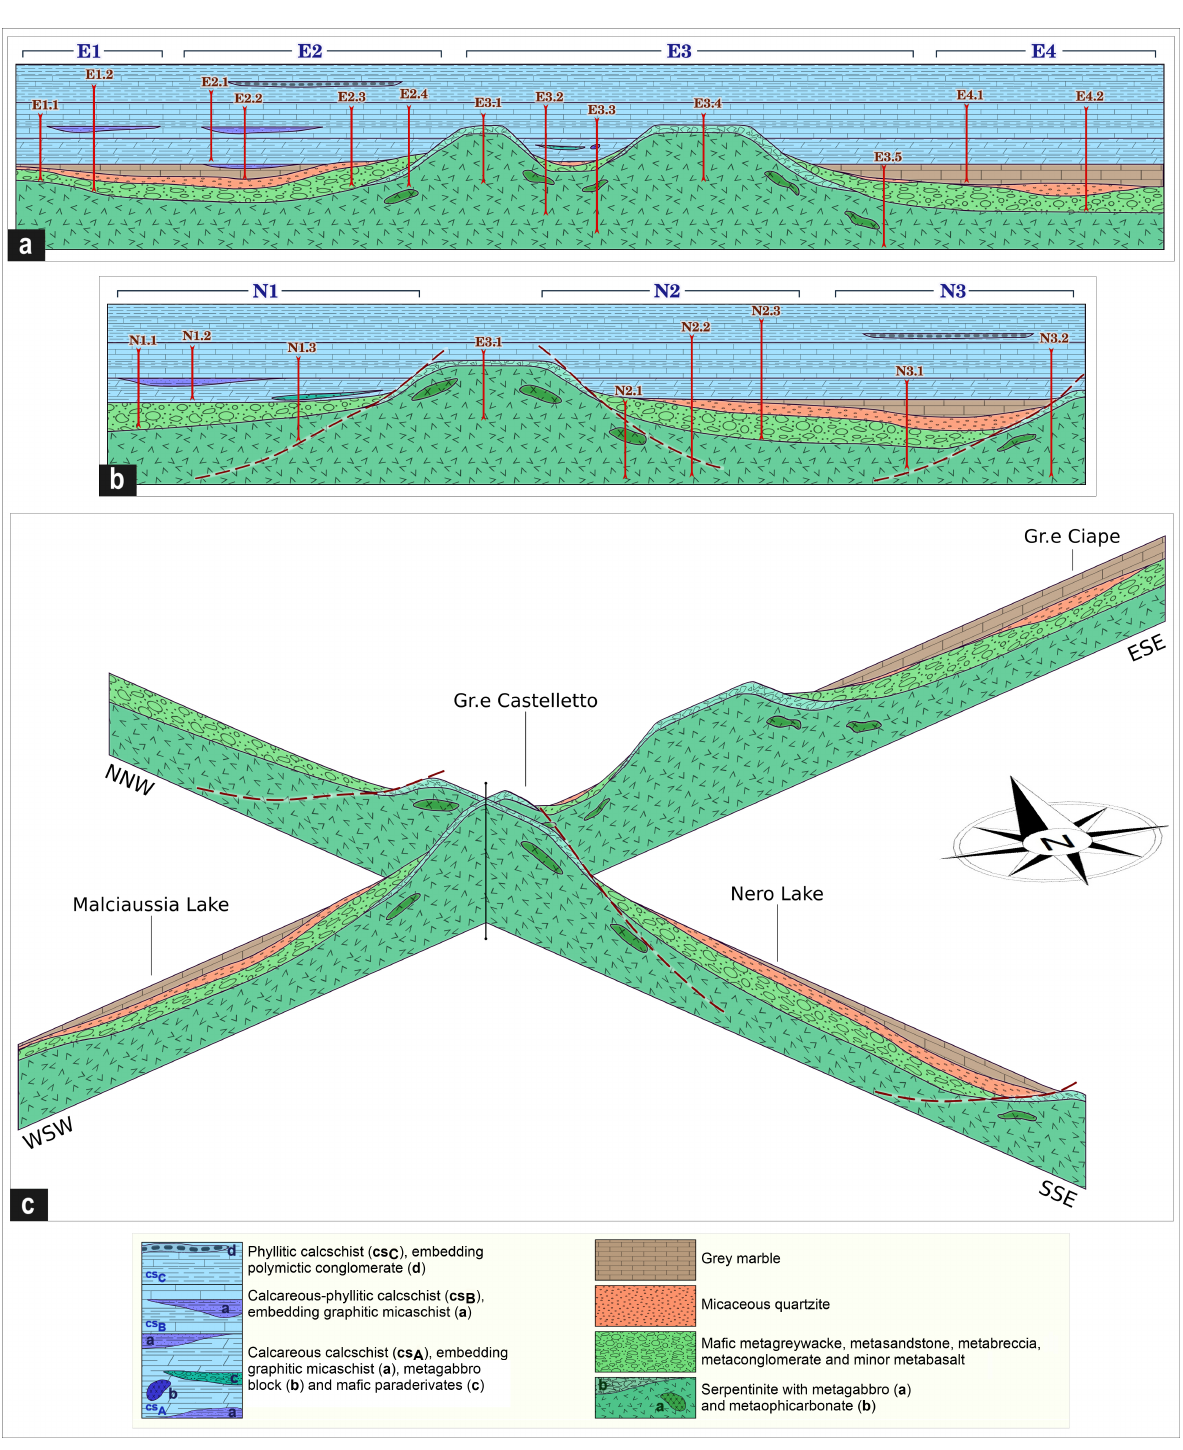
Figure 8. Simplified E–W ( a ) and N–S ( b ) striking reconstructions (not to scale) of the intra-oceanic (pre-orogenic) tectono- stratigraphic seafloor architecture of the Alpine Tethys in the studied sector at time of calcschist deposition (i.e., Late Cretaceous–Early Palaeocene?). Dark red dotted lines show the position of inferred faults, bounding high sectors. The red vertical lines show the position of the lithostratigraphic columns of Figure 6 (see text for details). ( c ) Fence diagram showing the lateral and vertical heterogeneities within the reconstructed Jurassic succession of the Alpine Tethys in the IPZ. The whole calcschist succession has been omitted to better show the inherited Jurassic basin floor physiography. The black central vertical line represents the E3.1 lithostratigraphic column, which is present in both the